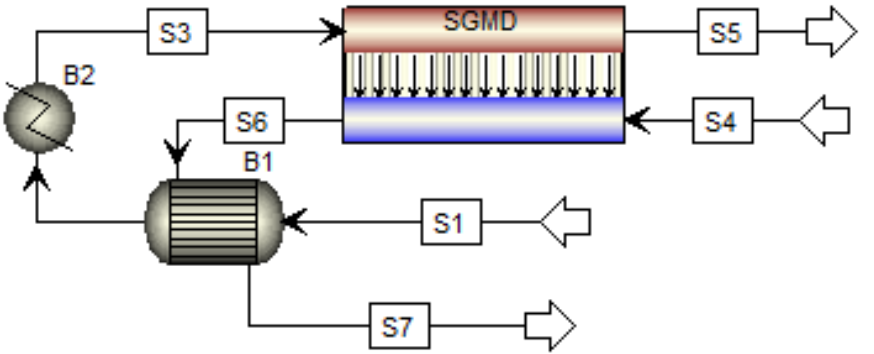
Figure B2. Flowchart of a base case SGMD-based desalination process.